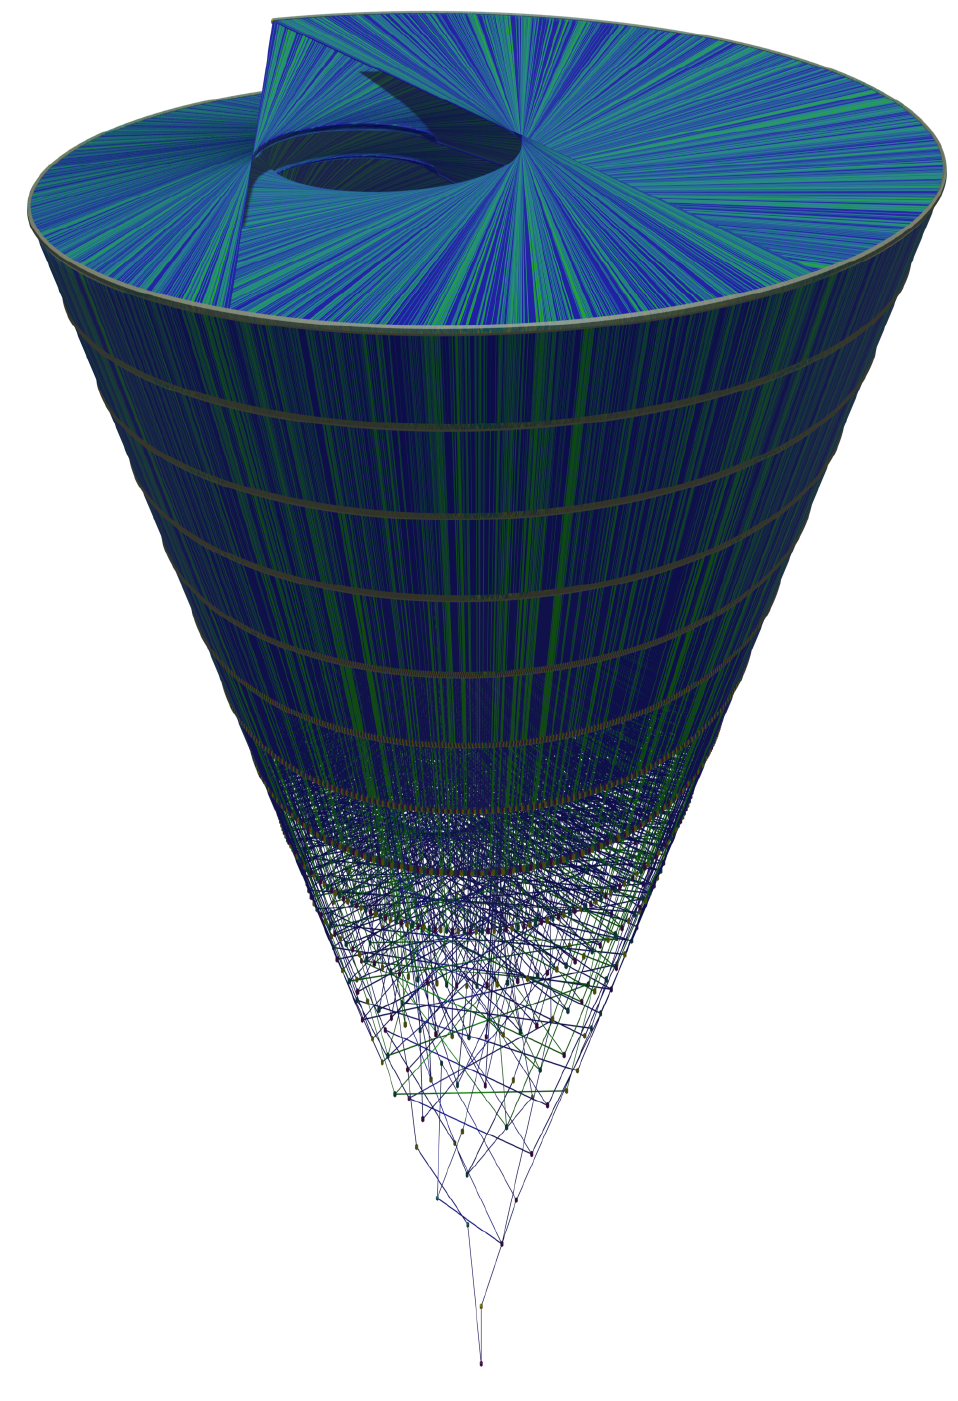
Figure 25. The Golden Automaton starting from 161 with all its collision edges, with the one starting from 1 shown in green. Although they are related, both the side and top distributions of the green edges can be used for cryptographic applications. The angle of the display remains important for scannable applications, as only the central convexoid of the figure may be used as a standard reference for the scan and must therefore be visible or otherwise indicated even if only the side lines are